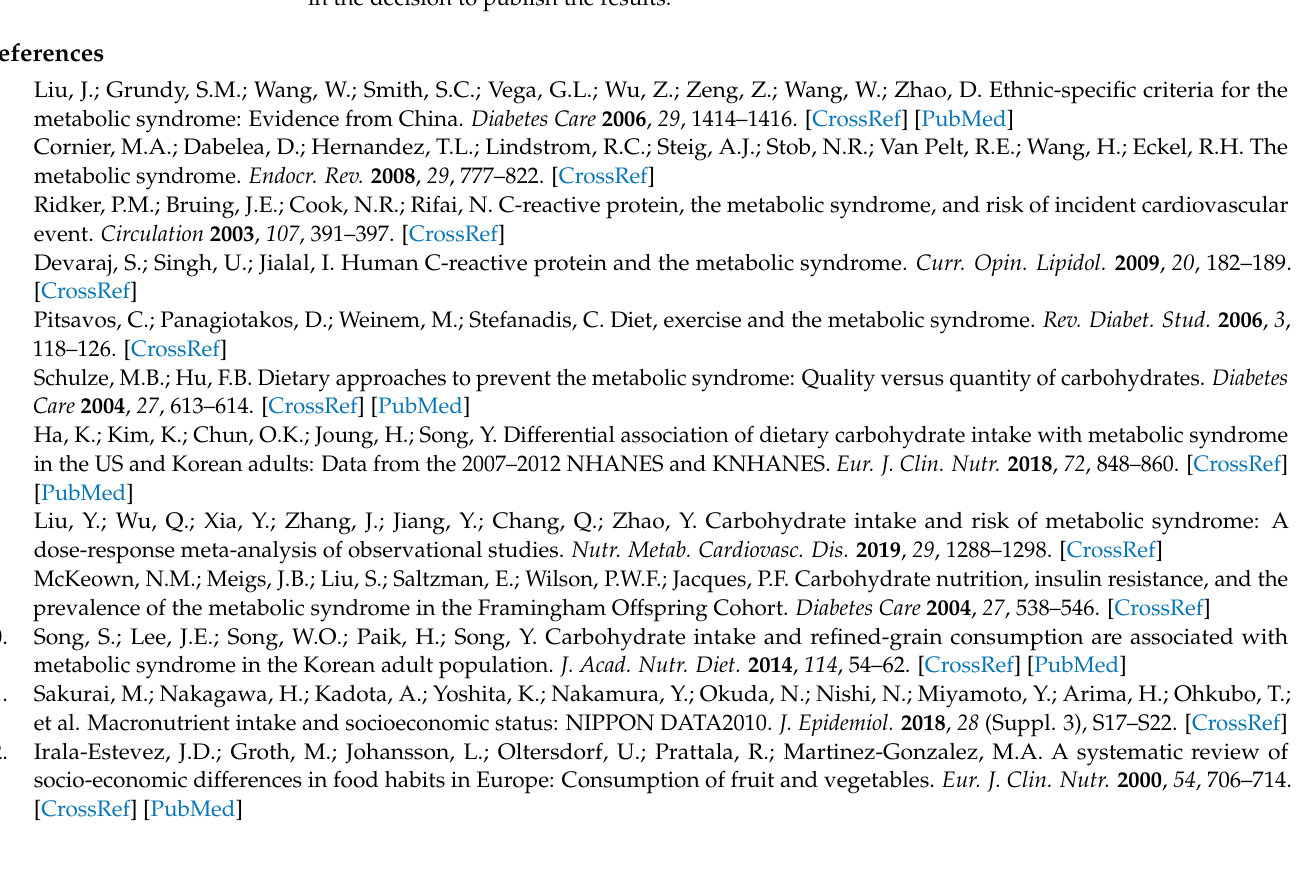
metabolic syndrome status. Table S2: Daily intake of energy and nutrients in the subjects according to carbohydrate intake in controls. Table S3: Food-group intake according to the level of carbohydrate intake in controls. Table S4: Association between carbohydrate intake and the risk of metabolic syndrome, stratified by the intakes of different food